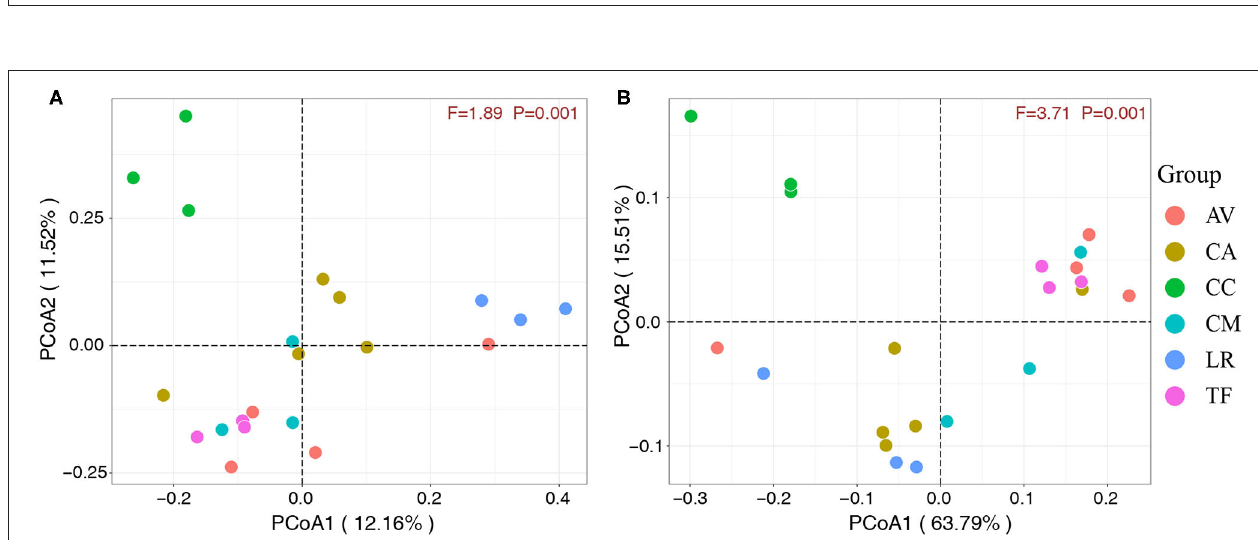
FIGURE 5 | Principal component analysis score plots based on unweighted (A) and weighted (B) UniFrac distance. Each point represents the mean principal component scores of all samples from one species at one time point. AV, demoiselle crane ( Anthropoides virgo ); CA, black swan ( Cygnus atratus ); CC, whooper Swan ( Cygnus cygnus ); CM, muscovy duck ( Cairina moschata ); LR, relict gull ( Larus relictus ); TF, ruddy shelduck ( Tadorna ferruginea ).